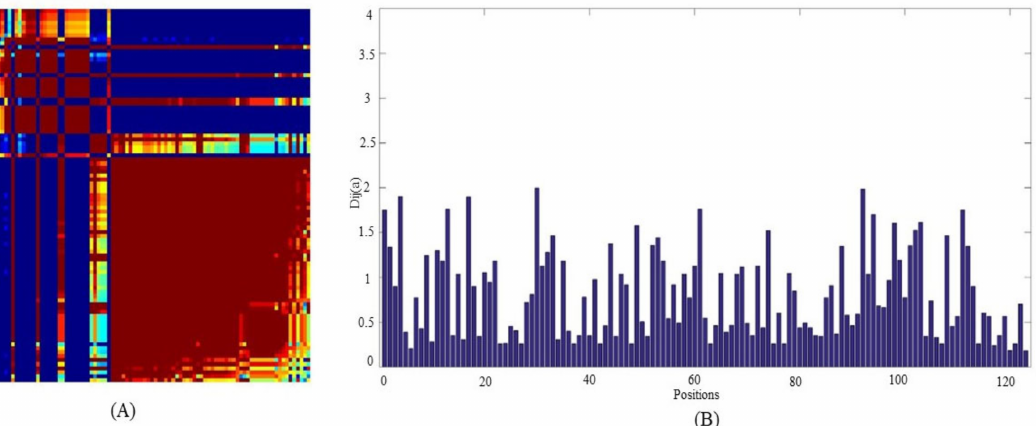
Figure 3. ( A ) Red, blue, and green sectors of a Statistical Coupling Analysis (SCA) matrix, with the red sector indicating highly conserved amino acid positions. ( B ) The conservedness score graph depicts the Dij value of a specific